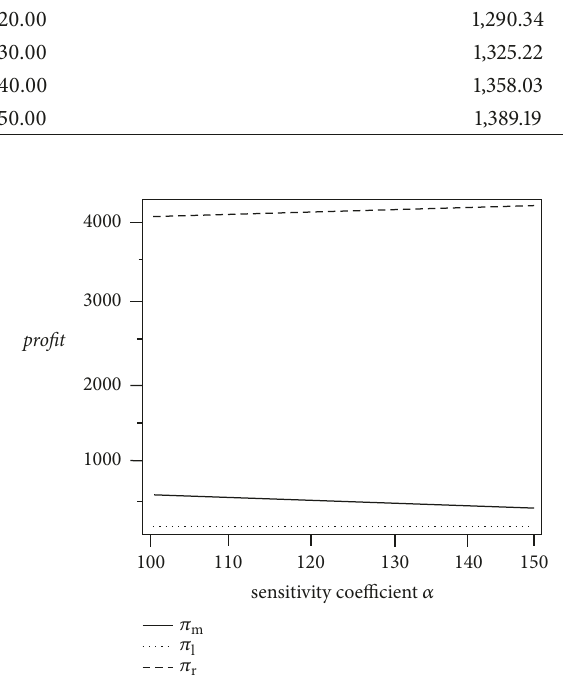
Figure4:Theeffectofthesensitivitycoefficientoftheorderquantity to the wholesale price on the supply chain members’